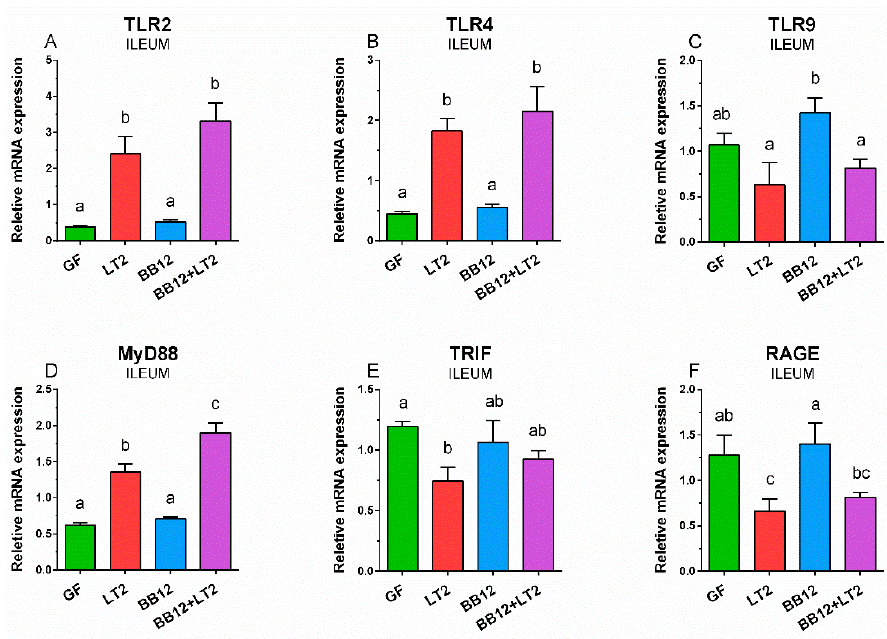
Figure 3. Relative expression (fold-change) of TLR2 ( A ), TLR4 ( B ), TLR9 ( C ), MyD88 ( D ), TRIF ( E ), and RAGE ( F ) mRNA in the ileum of the one-week-old gnotobiotic piglets: germ-free (GF), infected with S . Typhimurium LT2 for 24 h (LT2), associated with B. animalis subsp. lactis BB-12 (BB12), and associated with BB12 and infected with LT2 for 24 h (BB12 + LT2). Six samples from each group were analyzed, and statistical differences were calculated by a two-way ANOVA with Tukey’s multiple comparison post hoc test. The values are presented as mean + SEM, and a p < 0.05 among groups is denoted by different letters above the columns.